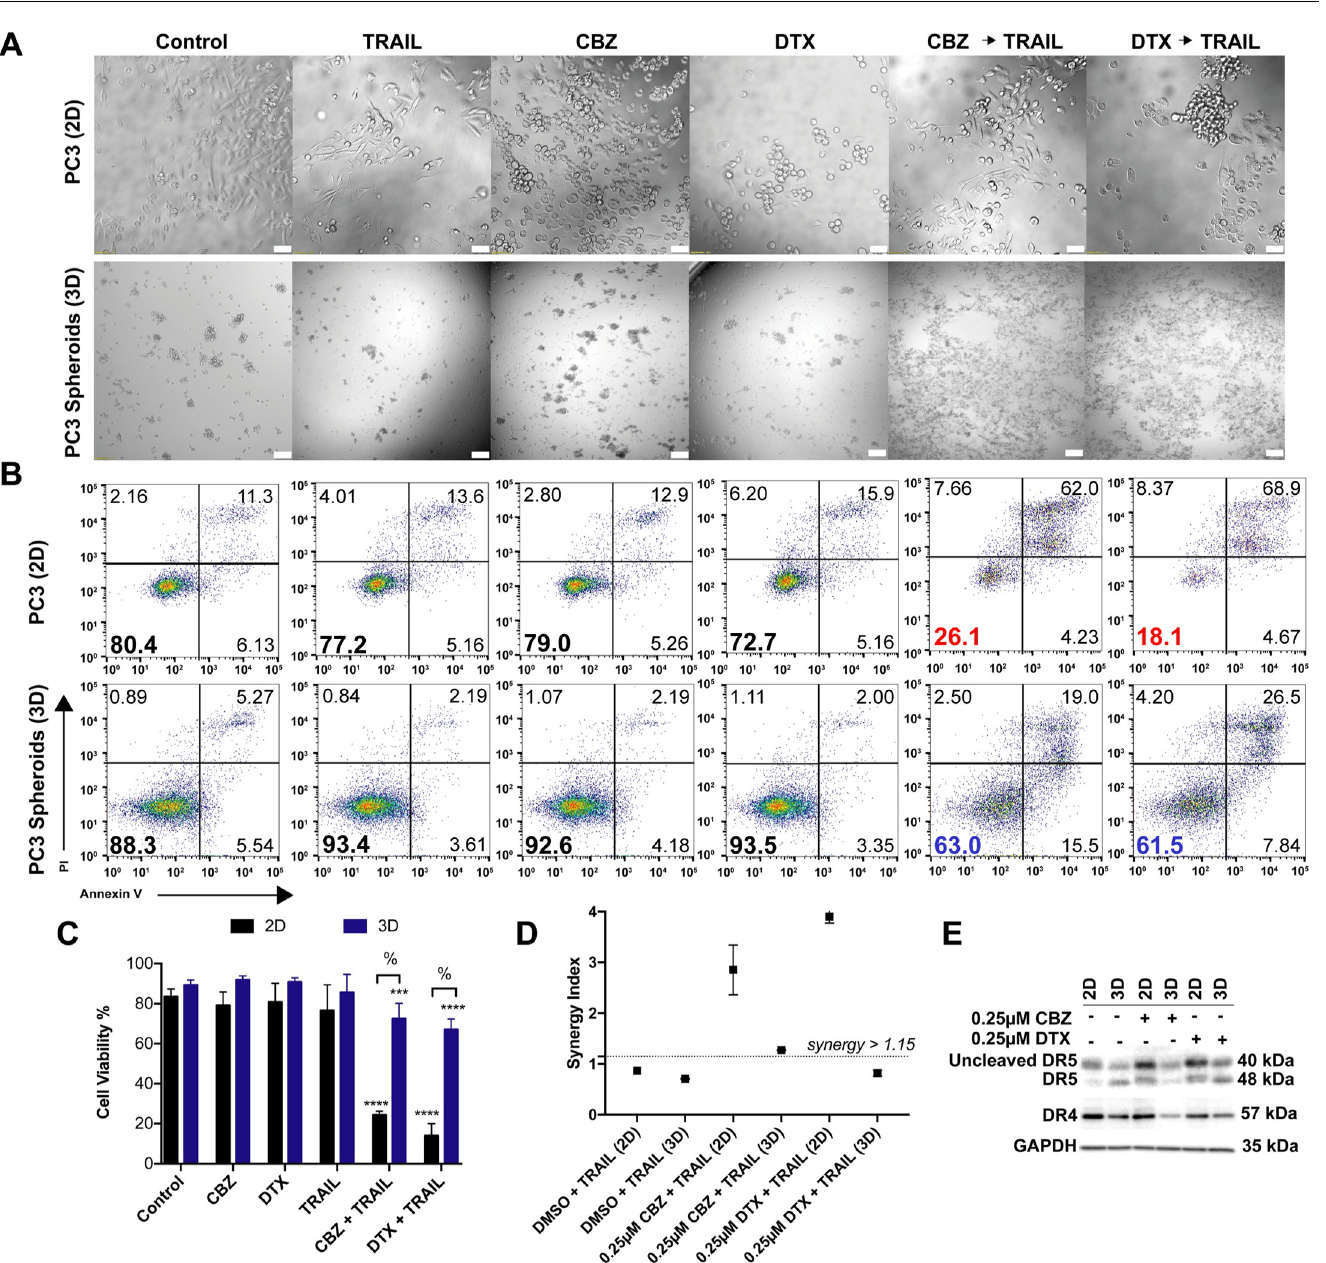
Fig 6. PC3 spheroids show a lower expression of death receptors and are more resistant to taxane plus TRAIL combination therapy. A . Brightfield images of PC3 cells cultured as 2D monolayer and 3D spheroids after 24 hr treatment exposure with DMSO, TRAIL, CBZ, DTX, CBZ + TRAIL, DTX + TRAIL. Scale bar = 50 μ m (top row) and 100 μ m (bottom row). B . Representative flow cytometry plots of 2D and 3D PC3 cells indicating apoptosis based on treatment conditions. C . Annexin-V/ PI assay results quantifying viability of 2D and 3D PC3 cells under different treatment conditions (n = 6). D . Graph displaying synergistic anti-tumor effect of combined taxane and TRAIL in PC3 cells by Jin’s formula (n = 3). E . Western blot of death receptor expression in 2D and 3D PC3 cells treated with DMSO, CBZ or DTX. The values represent the mean ± SD. ��� p < 0.001, ���� p � 0.0001, significantly different from control, % p < 0.0001, significantly different 2D vs 3D